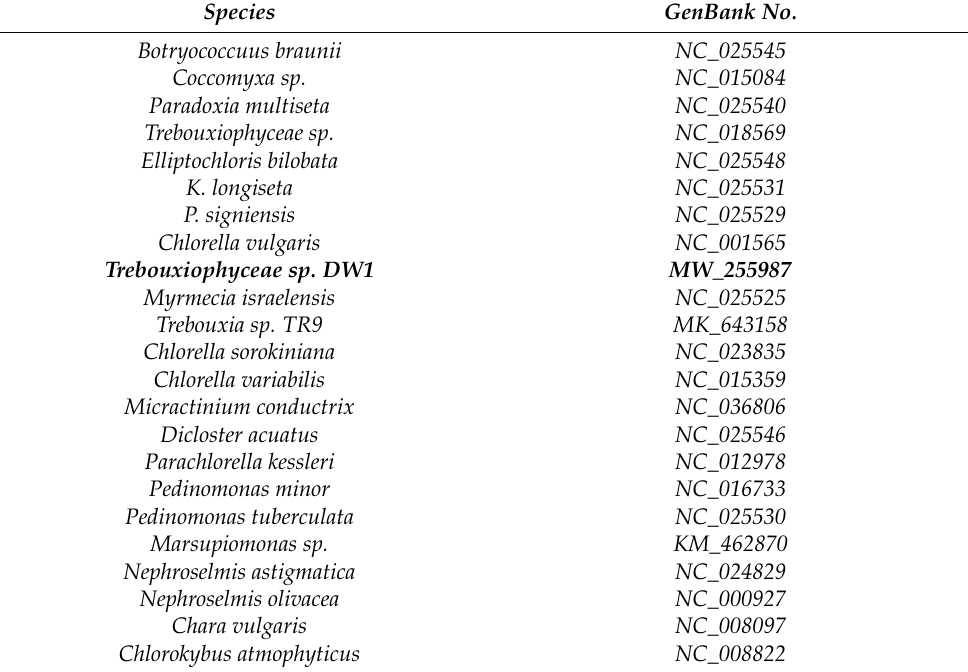
Table 1. Species and GenBank accession number used for phylogenetic